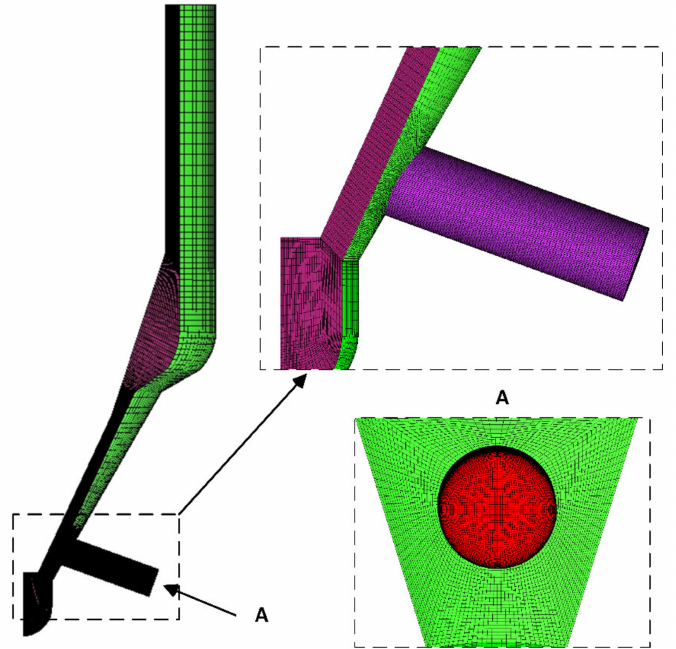
Figure 4. Mesh model of the investigated nozzle (partial enlargements are shown on the